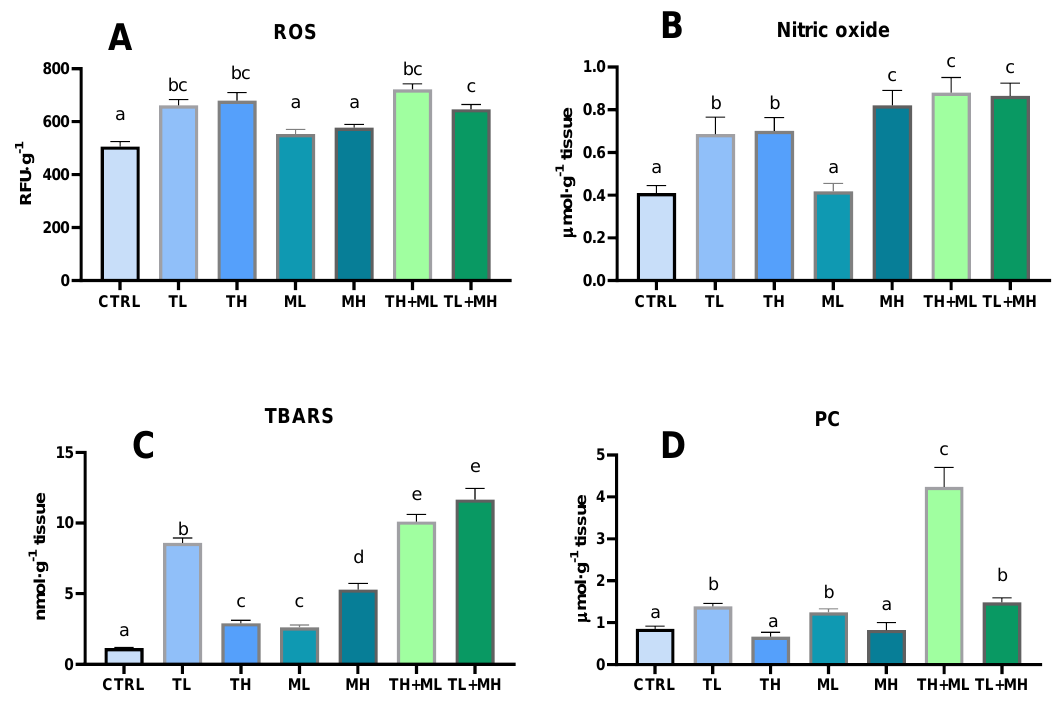
Figure 2. Effects of terbuthylazine (2 µ g L − 1 (TL) and 30 µ g L − 1 (TH)) and malathion (5 µ g L − 1 (ML) and 50 µ g L − 1 (MH)) exposures on reactive oxygen and nitrogen species as well as oxidative lesions in the liver of zebrafish. ( A ) Reactive oxygen species; ( B ) Nitric oxide; ( C ) TBA-reactive substances; D , Protein carbonyls. When columns share the different letters (a–e), they represent significantly different values ( p < 0.05). The means and the standard errors of the mean are presented. N = 6.